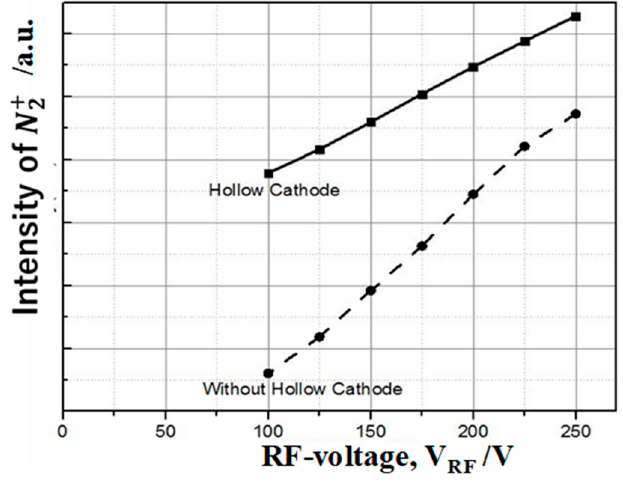
Figure 5. Variation in N (cid:2870)(cid:2878) peak intensity with the increase in RF-voltage in the plasma diagnosis, with and without the use of the hollow cathode device in cases where p = 50 Pa and V DC = − 500 V.